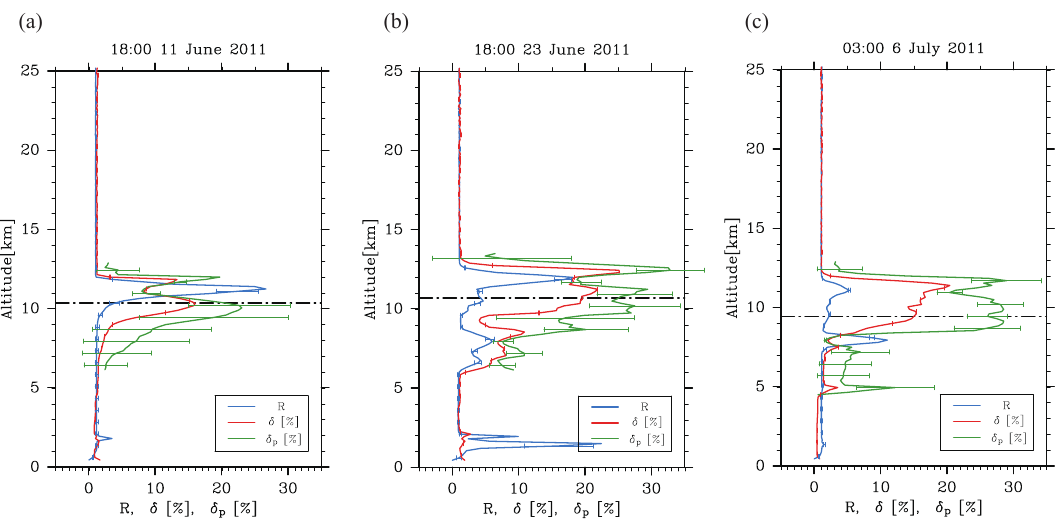
Figure 4. Vertical profiles of the backscattering ratio R (blue line), the total depolarization ratio δ (red line) and the particle depolarization ratio δ p (green line) observed on (a) 11 June at 18:00LT, (b) 23 June at 18:00LT, and (c) 6 July at 03:00LT. The horizontal dot-dash line in each panel shows tropopause height: (a) 10.3km, (b) 10.6km and (c) 9.4km. The volcanic aerosol layers are indicated by the R , δ and δ p peaks above the tropopause height. The error bars are also shown for R , δ , and δ p